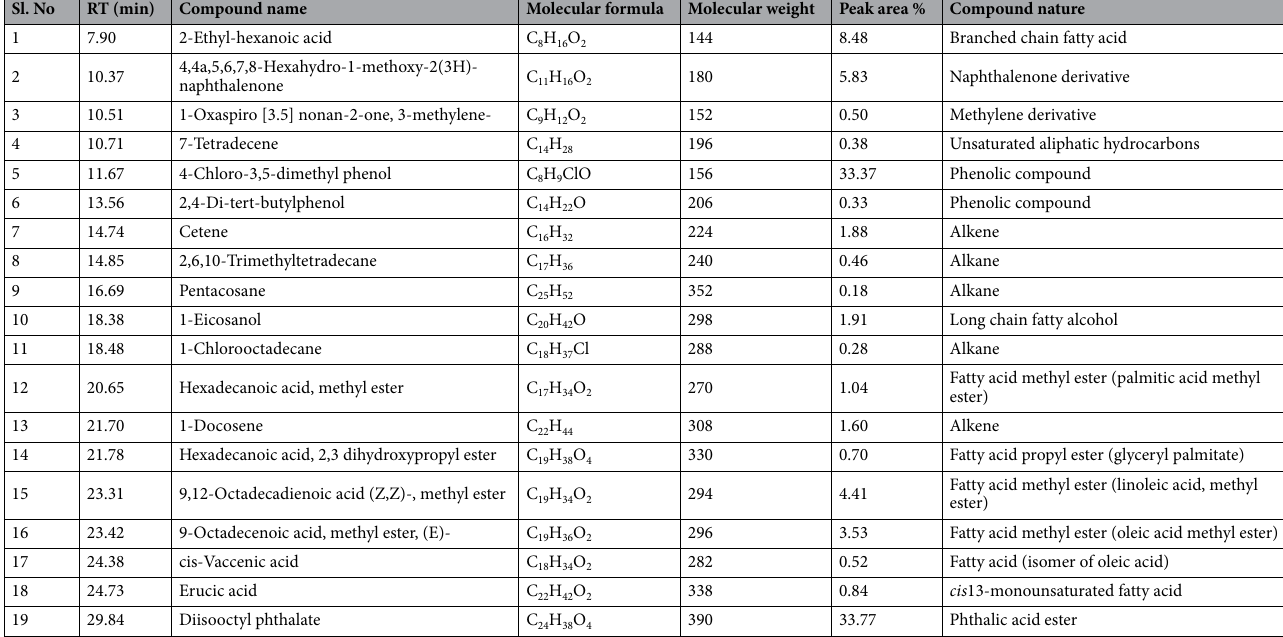
Table 1. Chemical constituents and their retention time (min) identified in the ethyl acetate crude extract of Paecilomyces sp. (AUMC 15510) using gas chromatography-mass spectrometry. Sl. No. serial